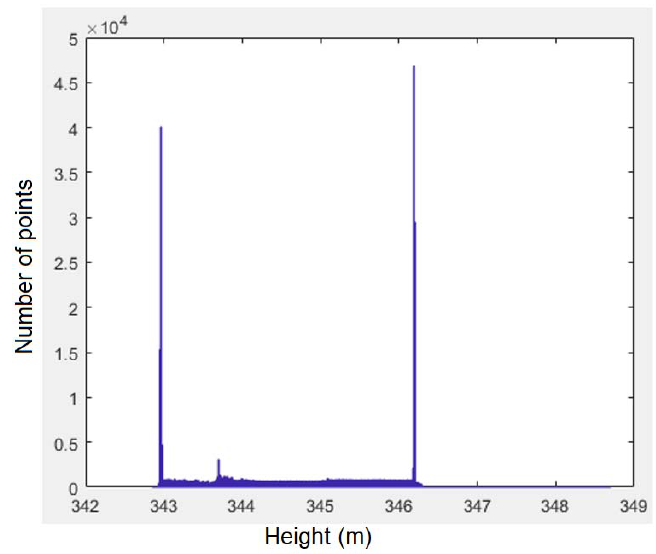
Figure 2. Z-histogram: histogram of the elevations of the points. The maximum values correspond to the floor and ceiling of the room.